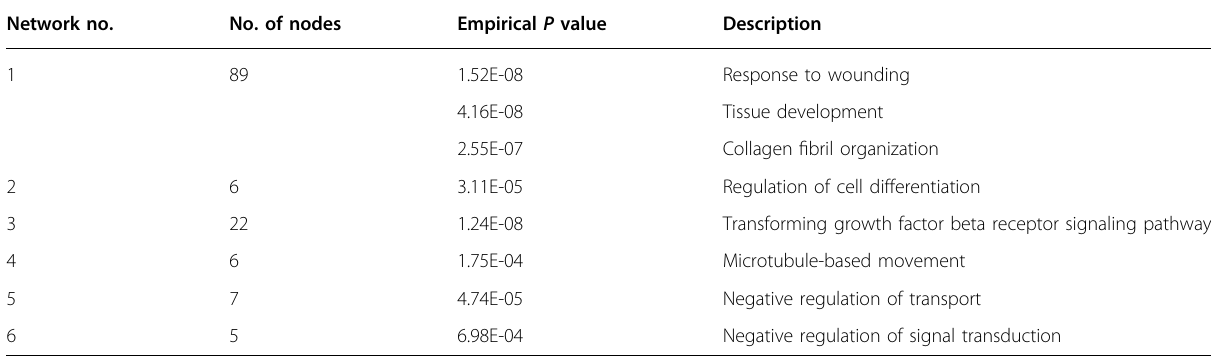
Table 1 Signi fi cantly enriched biological functions in each subnetwork Network